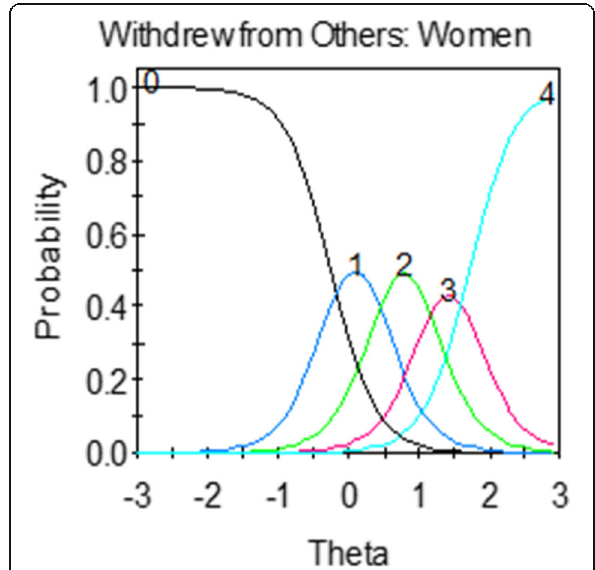
Fig. 1 Example of an item characteristic curve (ICC) or “ trace line ”